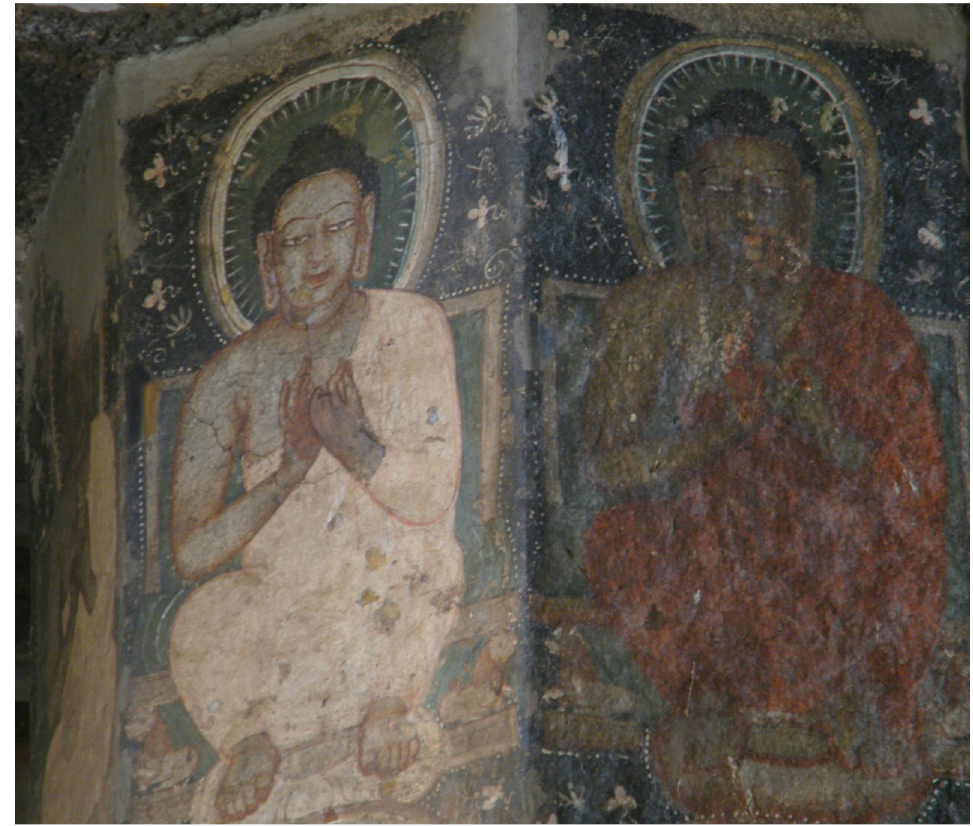
Figure 4. Intrusive mural on a pillar from Aja ṇṭ ā Cave 10, ca. 478–480 CE (Photograph by the au- thor).